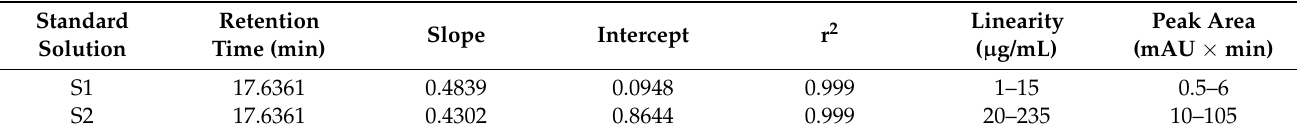
The quantification of CT in the assessed solutions was performed by HPLC, with respective CT retention times in different solvents (Figure 6).